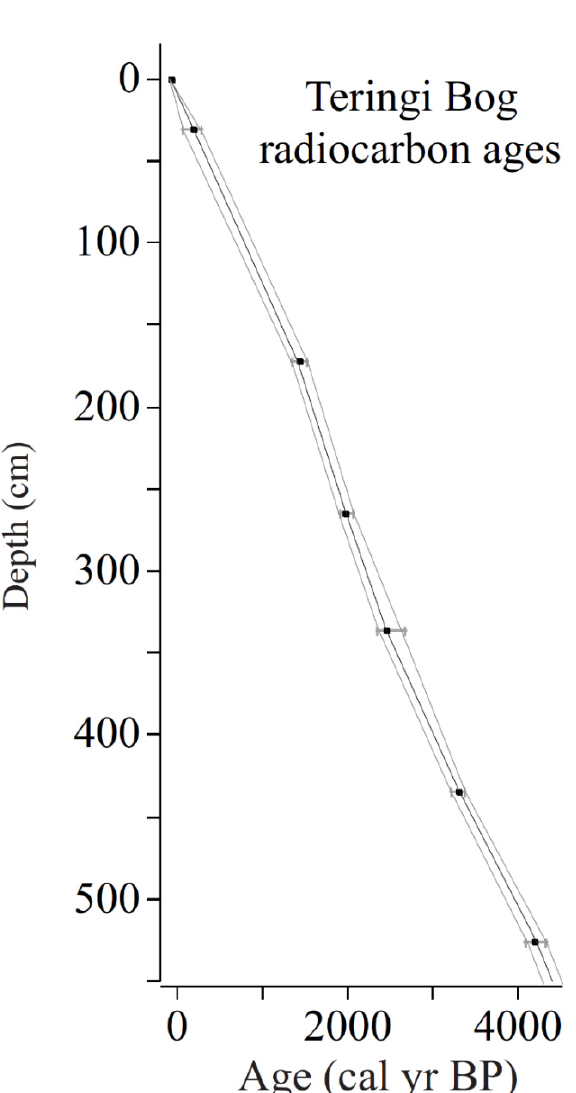
Figure 6. Age-depth model for Teringi Bog calculated with Bacon. The horizontal bars and grey lines represent the modeled calibration range of each 14 C sample (see Table 1).